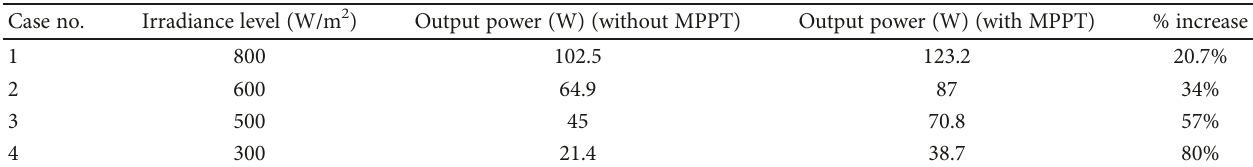
Figure 6: Surface view for fuzzy inputs ( P , dV) vs. output ( D ) (adappted from Allataifeh et al. [2]). Table 3: Comparison between output power values with and without MPPT.